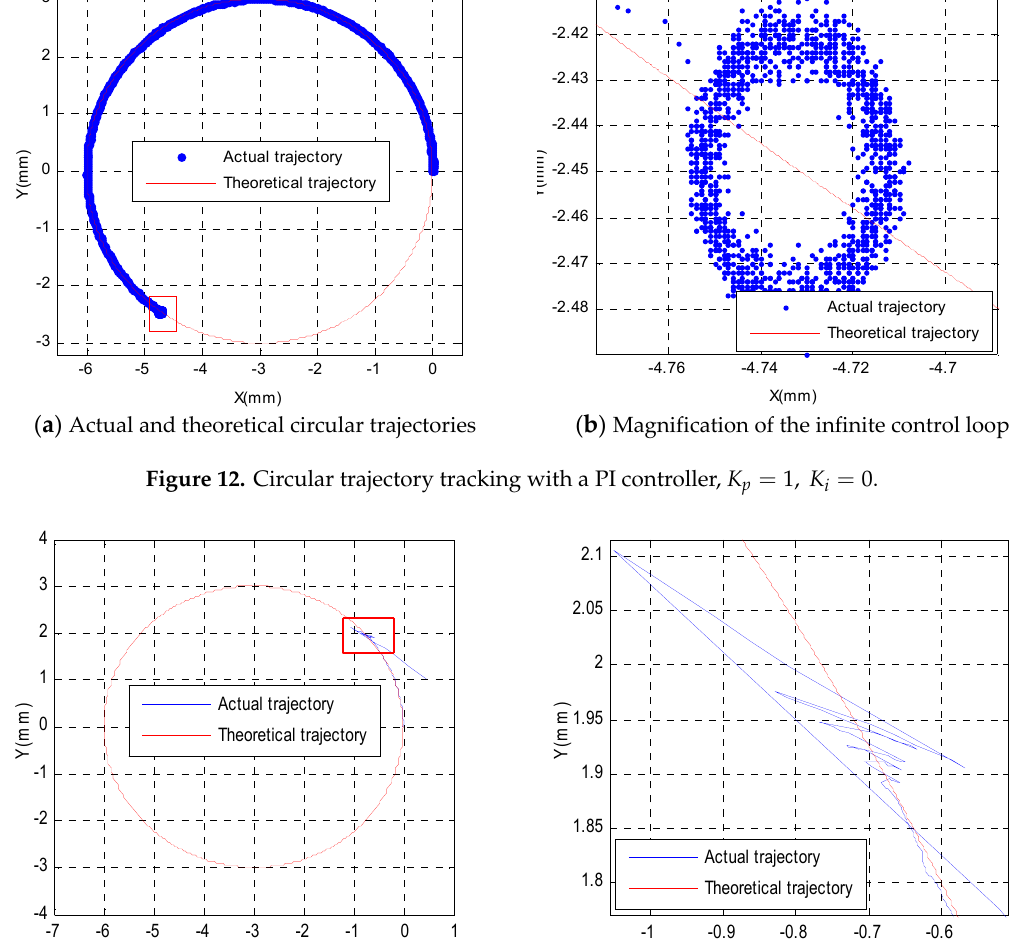
Figure 13. Circular trajectory tracking with a PI controller, 0.8, K = = .